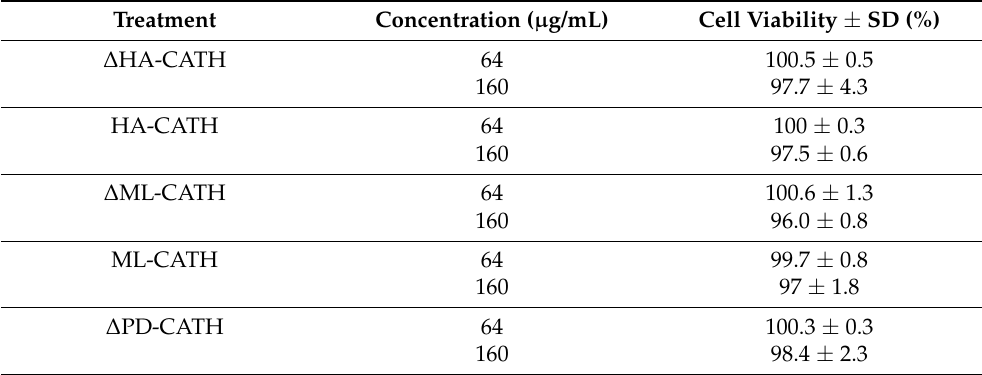
Table 4. Viability of HaCaT cells after the addition of bat cathelicidin-derived